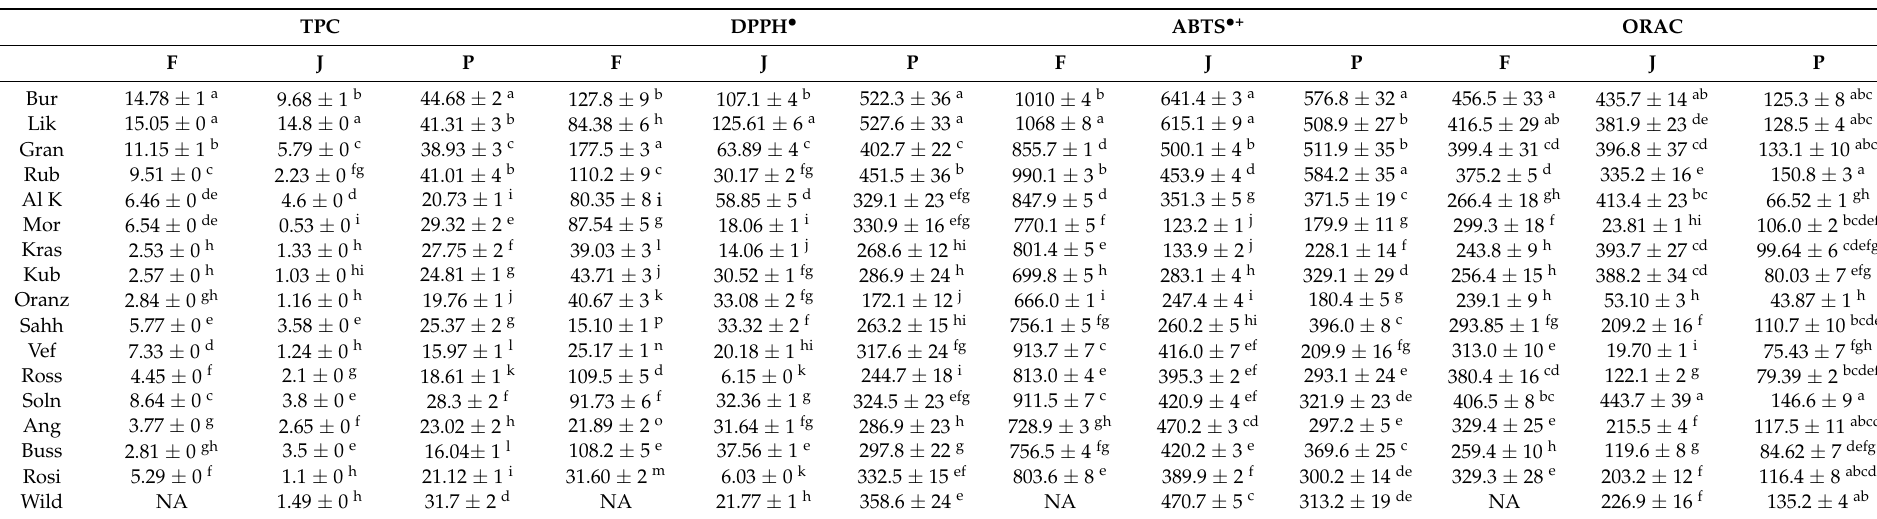
Table 2. Total phenolic content, SET- and HAT-type antioxidant activity of fruit, juice, and pomace of 16 rowanberry genotypes and wild